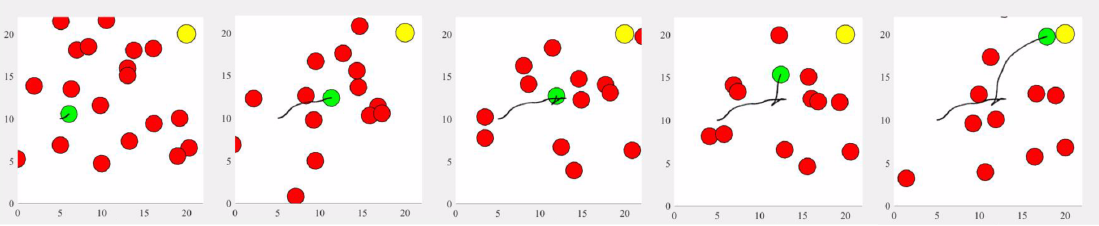
Figure 7. Avoiding multiple passive agents. Multiple snapshots at different time instances show a car-like robot, in green, navigates among multiple passive agents, in red, while moving towards a goal p g , in yellow. The passive agents are moving with arbitrary velocities. The probability that a passive agent will change its velocity within one second is 0.2. { β = 0.4 is set for the